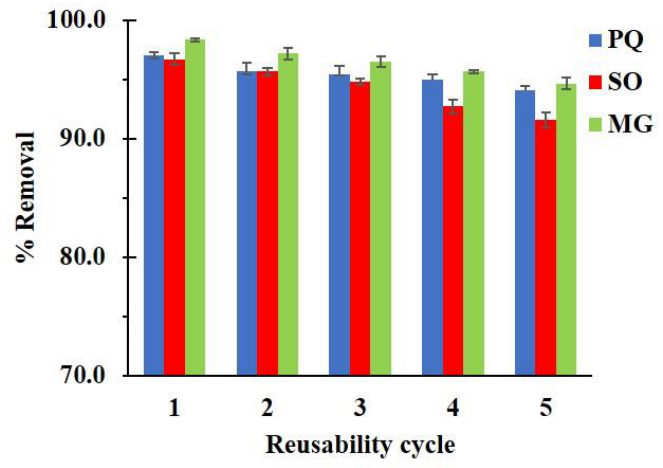
Figure 12. Reusability of C10D-P2 nanosponges (conditions: 2 g/L of adsorbent dosage, pH of 6.5 and temperature at 303 K).